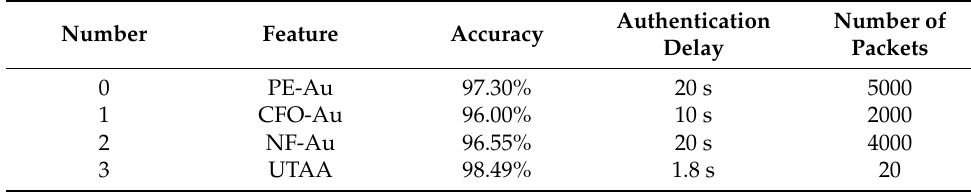
Table 2. Performance comparison of different baselines.